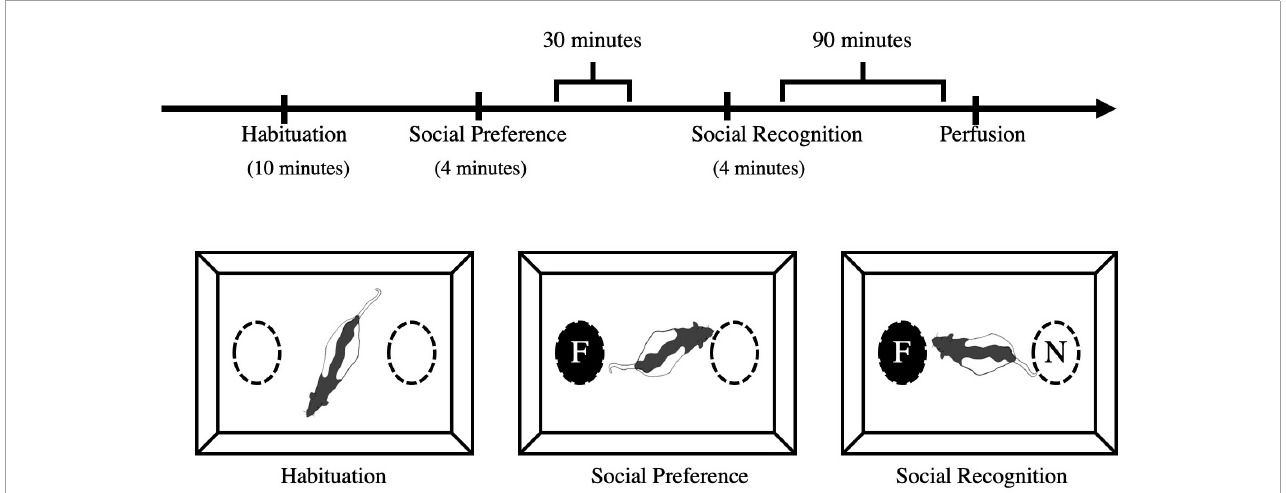
FIGURE2 Social preference and recognition schedule and apparatus. Experimental animals were initially habituated to the apparatus for 10 min. The acquisition phase was 4 min whereby test rats were exposed to a novel conspecific in a wire mesh cage. Thirty (30) minutes after the acquisition phase, test rats were presented with the familiar conspecific and a novel conspecific and tested for their social recognition memory. Tissue was collected via transcardial perfusion 90 min after social recognition. F, familiar conspecific; N, novel